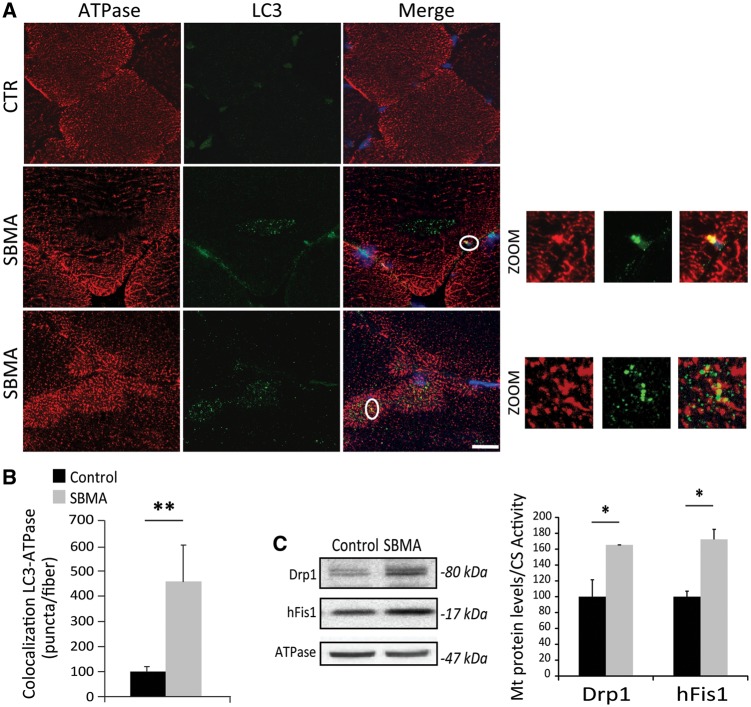
Increased mitophagy and mitochondrial fission proteins in the muscle of SBMA patients. (A) Representative images of anti-LC3 (green) and anti-ATPase (red) immunostaining of control and SBMA muscle tissues. Zoom: magnification of the marked area (circle). Scale bar, 20 μm. (B) Number of colocalized autophagosome-mitochondria (yellow puncta), measured as number of yellow puncta/fiber. Graph, mean ± SEM, n = 11 SBMA patients and 10 control subjects, n of fibers: 50 for each sample. (C) Western blotting analysis of Drp1 and hFis1 levels normalized to CS activity in mitochondria isolated from the quadriceps muscle of SBMA patients and control subjects. ATPase was used as loading control. Graph, mean ± SEM, n = 4 SBMA patients and 4 control subjects. Significance by Student’s t test: *P < 0.05, **P < 0.01.